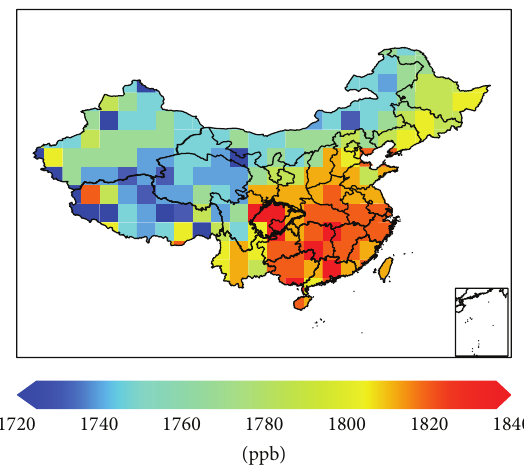
Figure 3: Spatial distribution of XCH 4 aggregated into 2.5 ∘ × 2.5 ∘